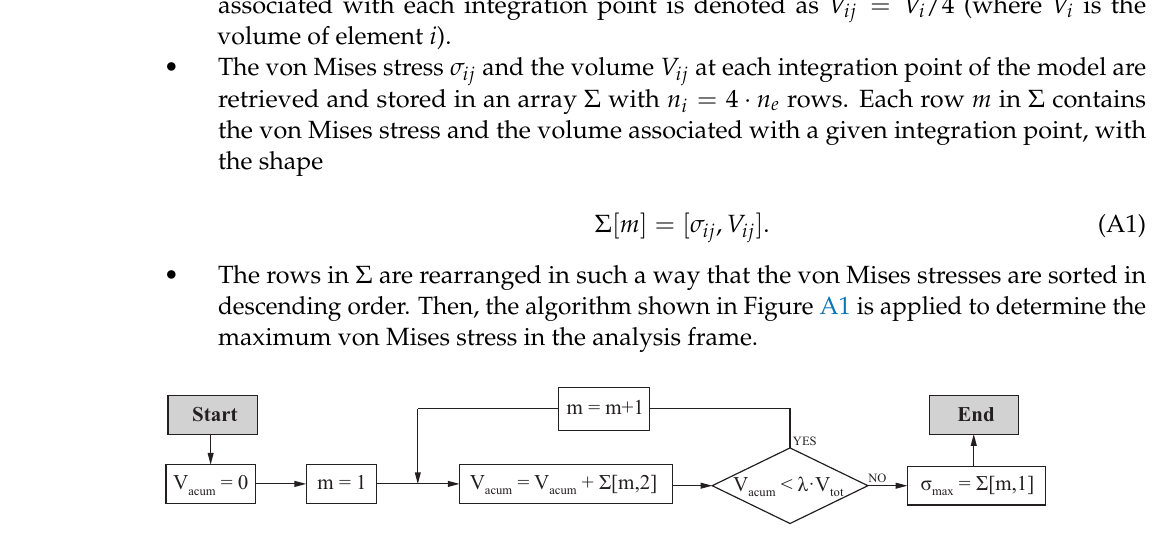
Figure A1. Algorithm to search for the maximum von Mises σ ij stress in the analysis frame after the array Σ is